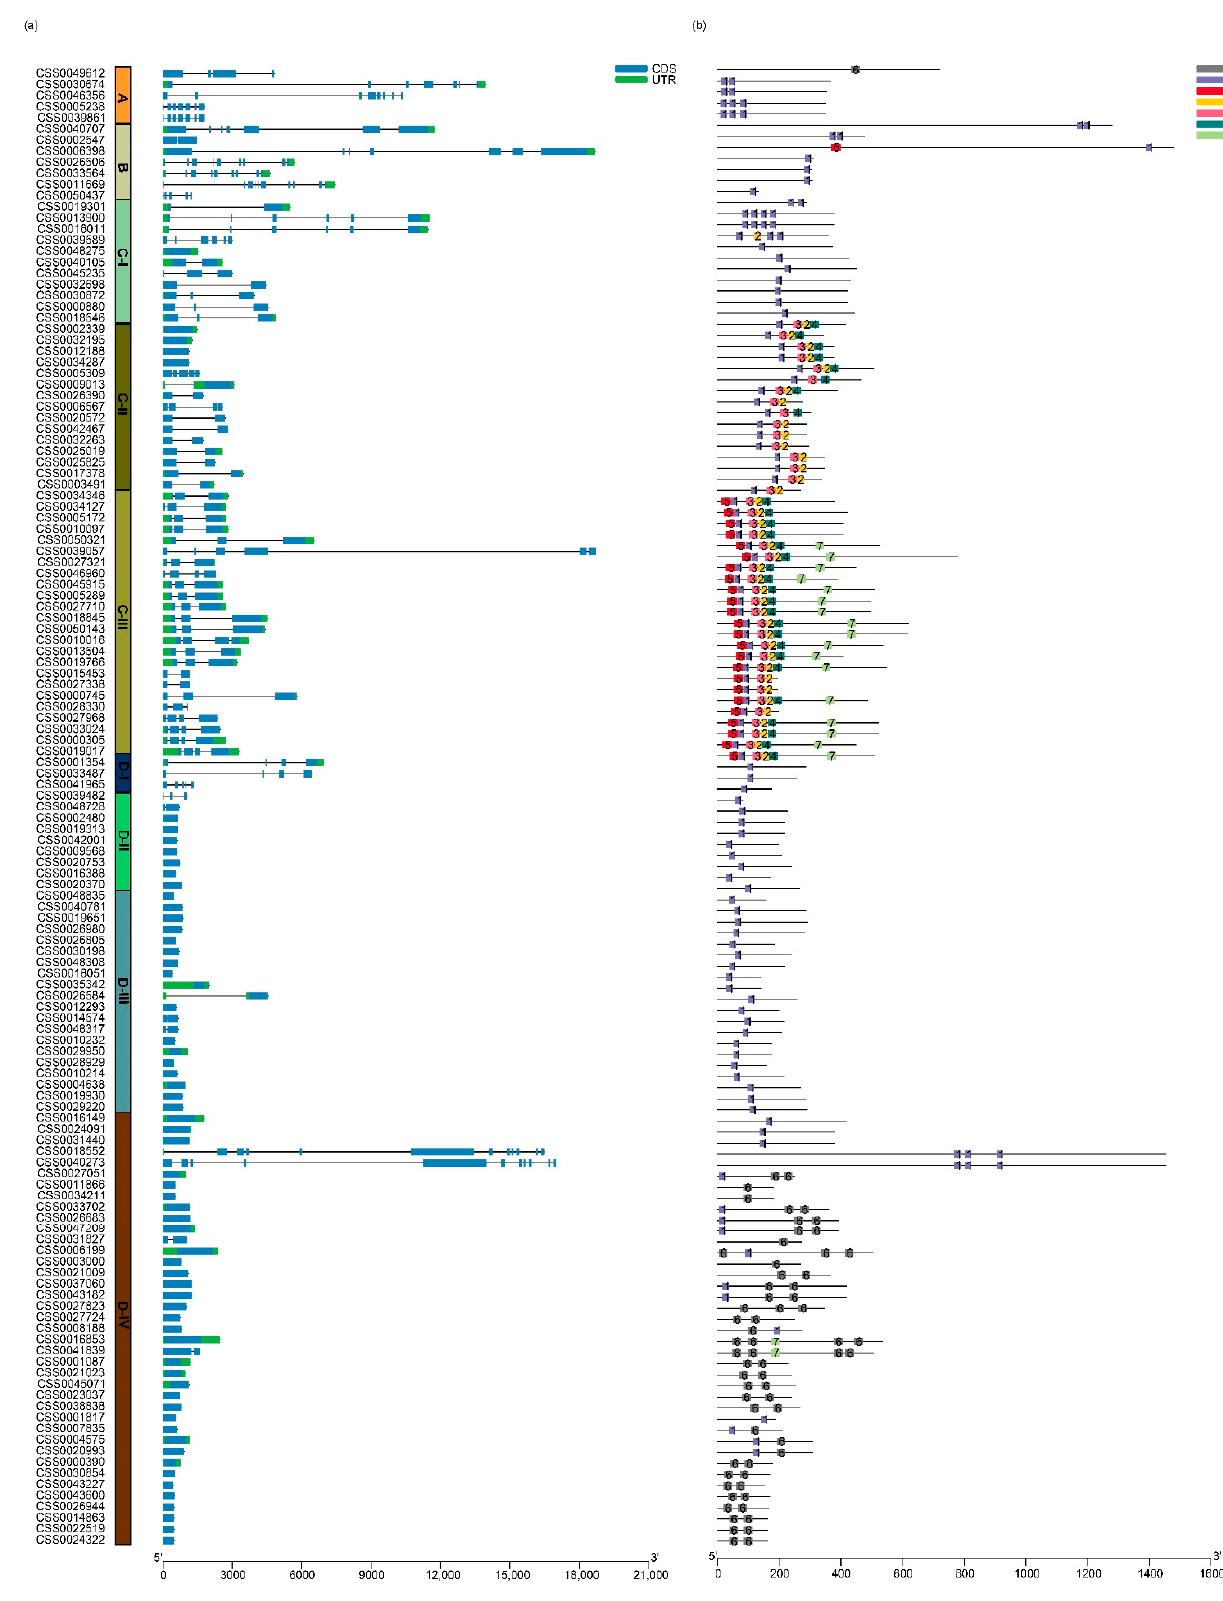
Figure 4. Gene structures and motif compositions of CsC2H2-ZFP genes. ( a ) The exon/intron structures of CsC2H2-ZFPs were predicted via TBtools. ( b ) The schematic representation of the conserved motifs as the colored box was identified by MEME web server. Intron is represented with a black line. The untranslated region (UTR) and coding sequence (CDS) are represented in colored boxes. The length of CsC2H2-ZFPs is indicated